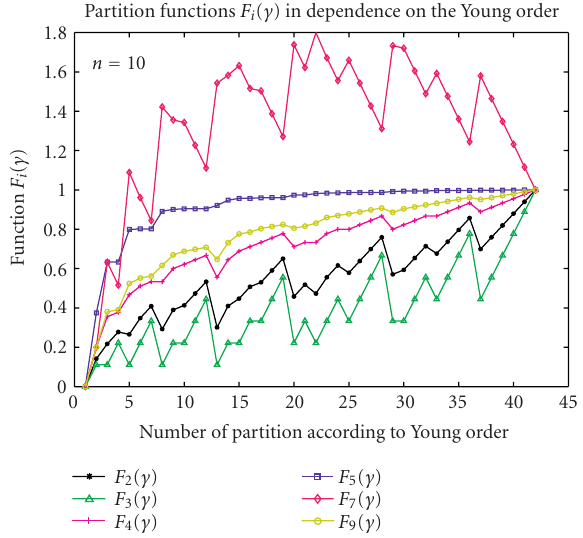
Figure 4.16. Dependence of partition functions F i ( γ ) on the Young order of partial sums for the Young diagrams in case of n =